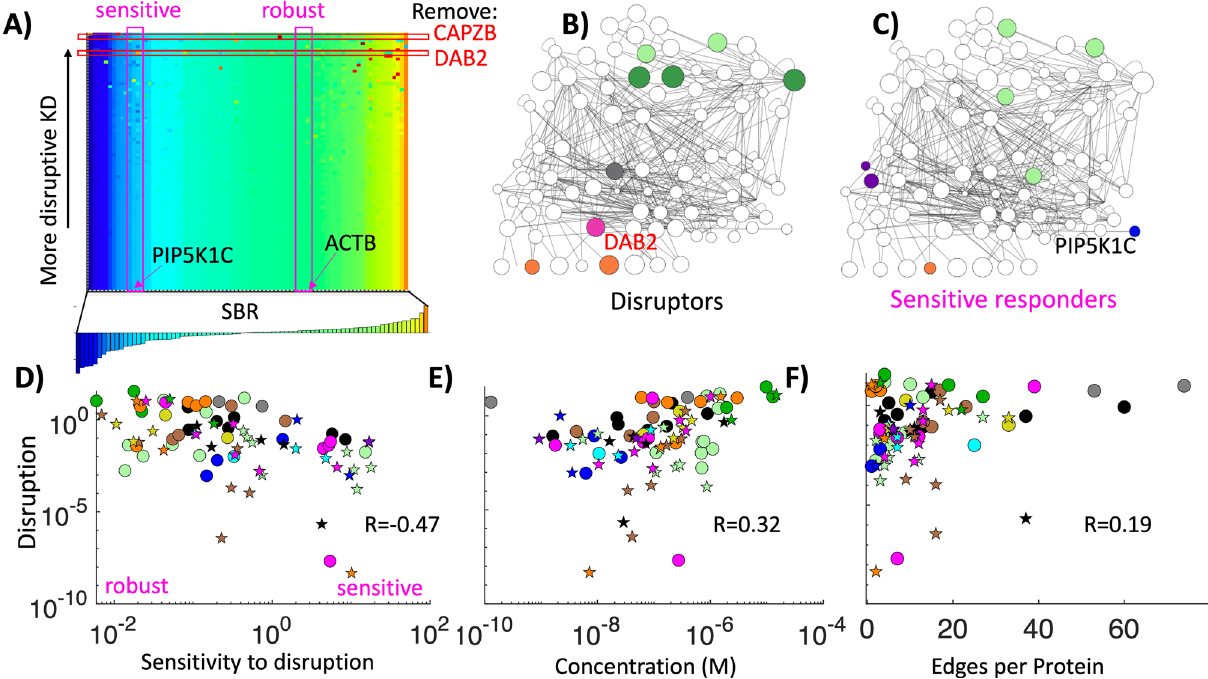
Figure 8. Systematic removal of each node from the network shows that highly abundant proteins control and disrupt stoichiometry upon removal most strongly. ( A ) The SBR distribution of the HeLa network (bottom inset) can change as a single node is removed (“KD: knockdowns”), where the color bar indicates the SBR value, with blue being most sub-stoichiometric and red being most super-stoichiometric. Each column thus records SBR of the same protein in the network. Each row follows a distinct knockdown, with rows at the top indicating the most disruptive removals (e.g. DAB2 and CAPZB). Some proteins are quite sensitive to these network perturbations with widely varying SBR values (magenta column: sensitive e.g. PIP5K1C), while others are robust to all single node perturbations (e.g. ACTB). ( B ) Most disruptive nodes are the most abundant proteins (dark green), other highly abundant and connected proteins (pink and gray), and a few cargo proteins that compete for binding. ( C ) Proteins most sensitive to network perturbations are more peripheral, including PIP5K1C, the co-factors that bind CLTC and HSPA8/HSC70, and several cytoskeletal proteins with few links. ( D ) Disruptive proteins are typically robust to network perturbations, producing an anti-correlation between disruption distance (Eq. 3) and sensitivity distance (Eq. 4). Proteins that have the largest impact on nearest neighbors are shown as circles, and on second nearest neighbors as stars, showing how both types of perturbations are common throughout the network. ( E ) Disruption is correlated with concentration, with R = 0.32. Notably, proteins with concentration > 2 μM are all strong disruptors. ( F ) Disruption has weaker correlation with edges, where only proteins that have > 50 edges are reliably disruptive to the network stoichiometry upon removal. Both disruption and sensitivity have almost the same values if they are evaluated on a per interface level first, before assigning a single SBR value to each protein, with a correlation of R = 0.98 between both Removal of hub proteins and highly abundant proteins is more disruptive to the network stoi‑ chiometry. After knocking down each protein from the network, we can rank which proteins have the big- gest impact on the SBR distribution in the network (Fig. 8A). We quantify the impact by the Euclidean squared distance between the SBRs across the network before ( SBR p ) and after a protein α is removed, N 2 − SBR = ( SBR α (3) Disruption (α) p ) p = 1 (cid:31) p where N is the number of proteins in both networks. Several proteins have virtually no impact on the network SBR when they are removed. When we sort the proteins that have the biggest impact, we find that the most abun- dant proteins (Fig. 8B) and the most highly connected proteins are all highly disruptive upon removal (Fig. 8E,F). In other words, the disruption index has a positive correlation with protein abundance, and a positive correlation with protein connectivity (Fig. 8E,F). The correlation is significant but not strong, in part because connectivity and copy numbers are not correlated, and because there are a number of coupled nodes that need not have high copies or connectivity to strongly disrupt the SBR of one protein, including CAPZB and CAPZA2 (Fig. 7), and the components ACTR3 and ARPC3 of the ARP2/3 complex. The same trends are observed across all three cell types, where HSPA8/HSC70 is always disruptive upon removal, as are at least one of the more abundant adap- tor proteins and cargos, such as DAB2 (Hela and fibroblast) and SNAP91/AP180 (synaptosome) (Fig. S12). The